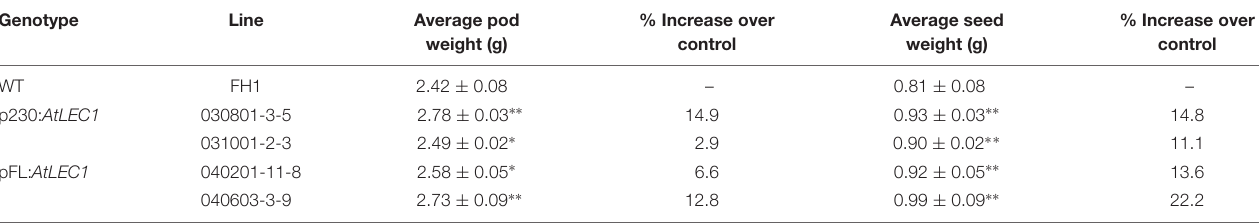
TABLE 2 | The Average weight of pods and seeds in T 3 transgenic peanut lines. Genotype Line Average pod